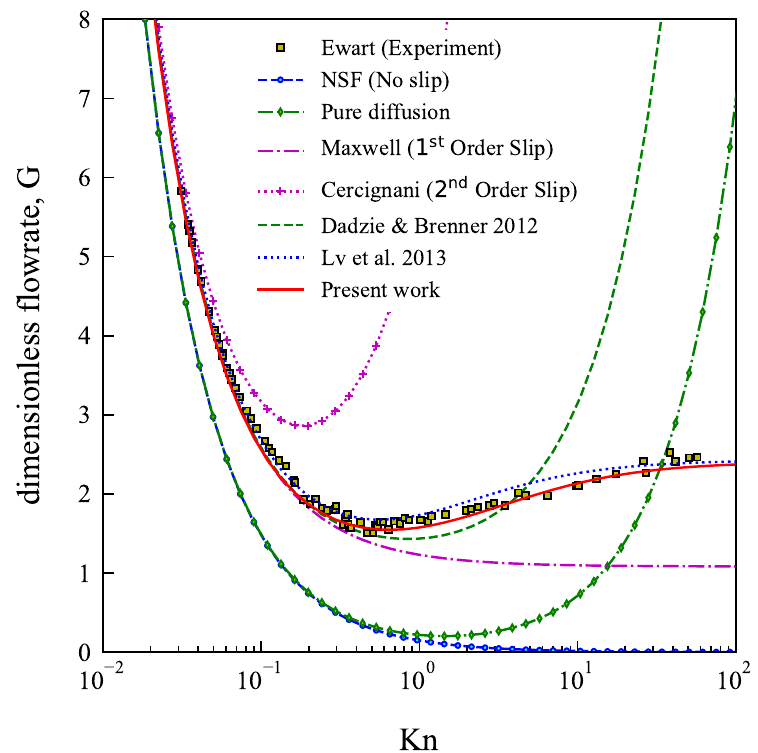
Figure 2. (Color Online) Comparison of dimensionless flow rate, G , versus the mean Knudsen number, Kn m , between current work and other analytical expressions and the experimental data by Ewart et al.